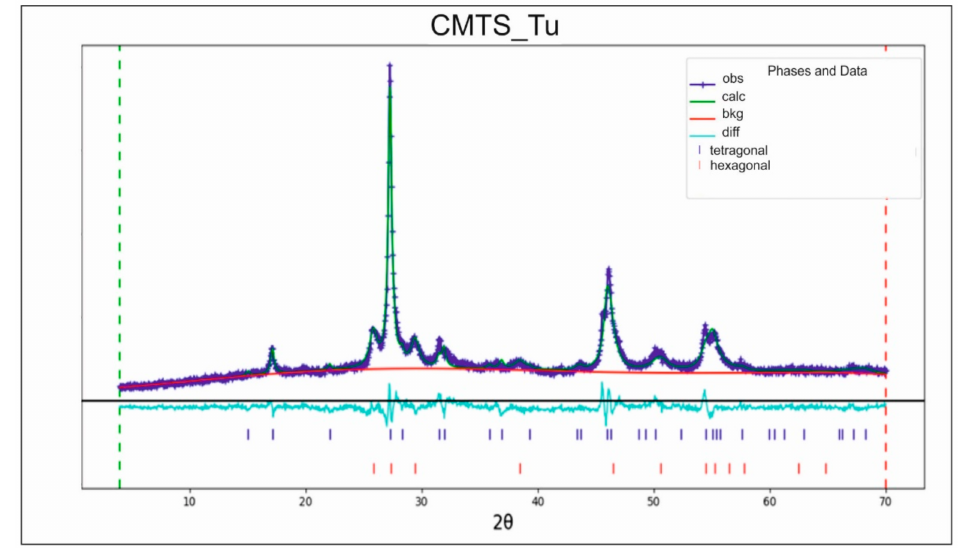
Figure 2. Refined XRD pattern of CMTS_Tu consisting of a mixture of tetragonal (62 wt.%) and